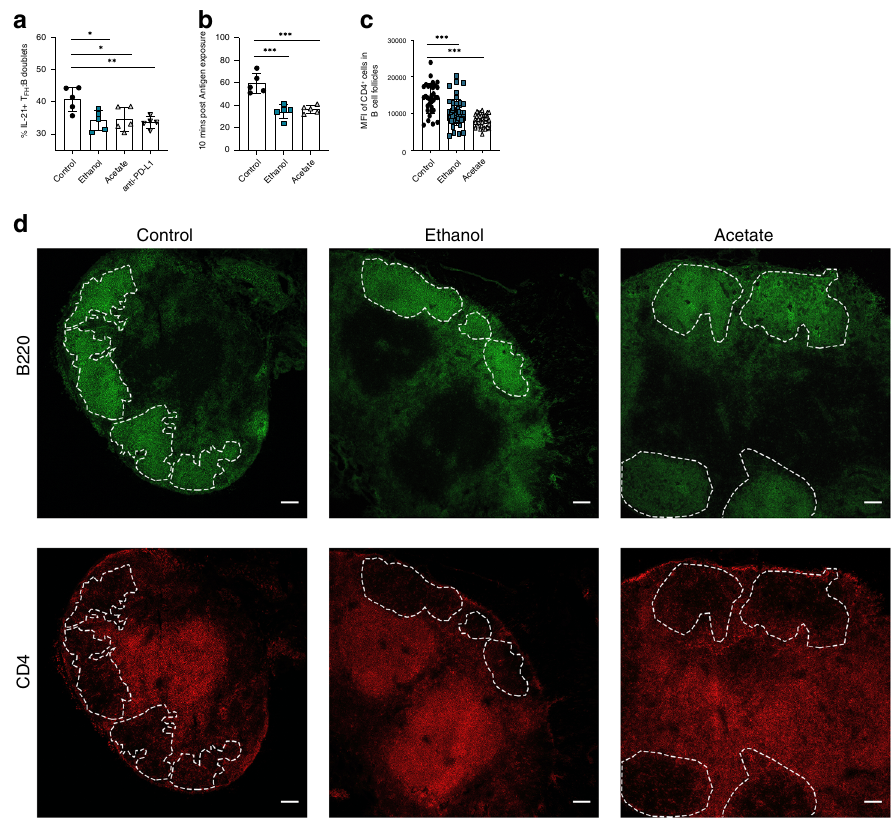
Fig. 8 Alcohol and acetate prevent the formation of T FH :B cell conjugates. a Flow cytometry analysis of IL-21 producing T FH :B cell conjugates in co- cultures of T FH and B cells activated with NP-CGG and treated either with water (control), or 10 mM ethanol, or 0.25 mM acetate, or 20 µ g mL − 1 anti-PD-L1 antibody. b Quanti fi cation of stable T FH :B cell conjugates formed in in vitro live cell imaging of T FH and B cell co-cultures activated with NP-CGG and treated either with water (control), or 10 mM ethanol, or 0.25 mM acetate. c Immuno fl uorescence analysis of CD4 + T cells ’ migration into B cell follicles in the draining lymph nodes of CIA mice exposed to either ethanol, acetate or vehicle. d Images representing CD4 + T cells within B cell follicles stained with anti-B220 (green) and anti-CD4 (red), followed by quanti fi cation of CD4 MFI within the B cell follicles. Scale bar, 100 µ m. Raw images at 10.6084/m9. fi gshare.11793798. a , b n = 5 mice per group per experiment and representative experiment of three independent experiments shown. c , d n = 5 mice per group per experiment (control: 32, ethanol: 50, acetate: 38 follicles analyzed) and representative experiment of three independent experiments shown. Data are expressed as mean ± SD. Statistical difference was determined by one-way ANOVA. * p < 0.05; ** p < 0.01; *** p <